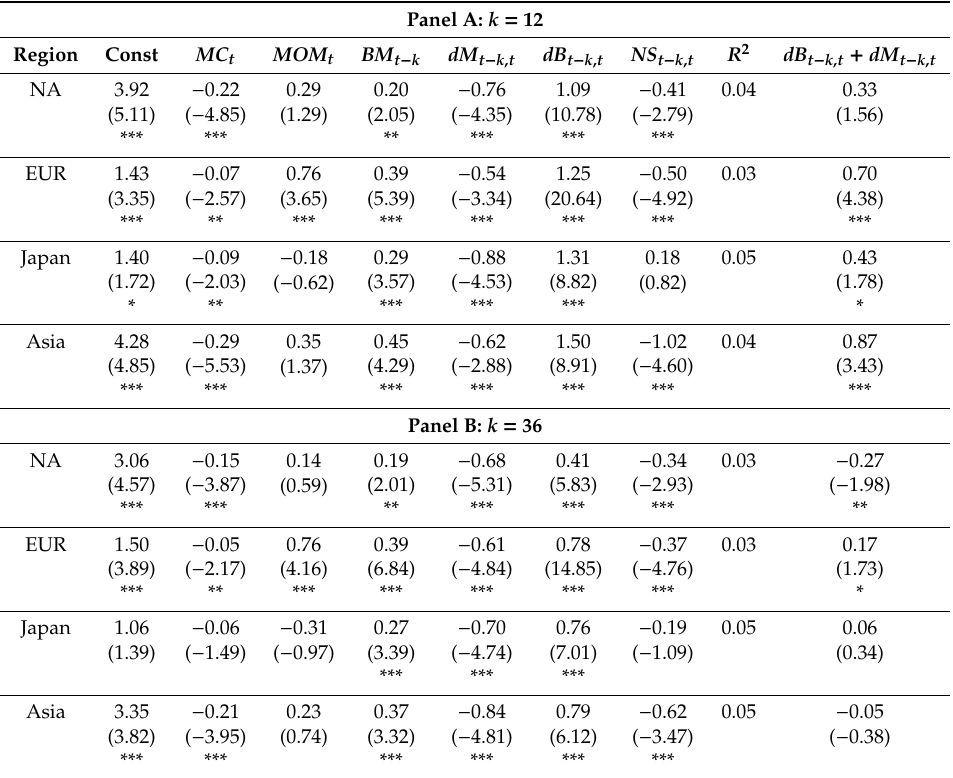
in Panel A report results for k = 12 and Panel B for k = 36. *** / ** / * indicates significance at the 1, 5, and 10% level, respectively.